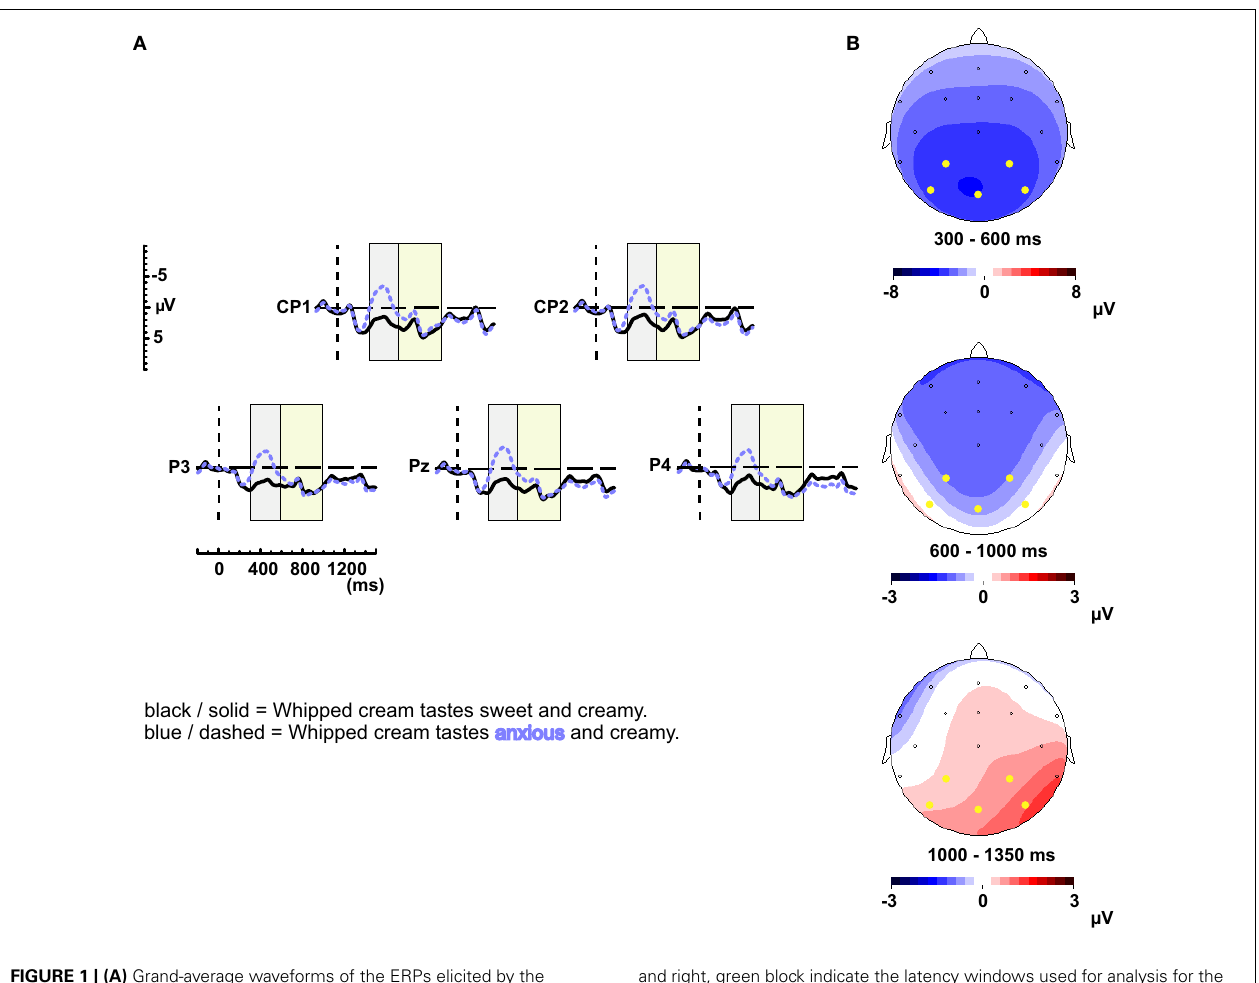
FIGURE 1 | (A) Grand-average waveforms of the ERPs elicited by the semantic anomalies (dashed, blue line) and their correct controls (solid, black line) for electrodes CP1, CP2, P3, Pz, and P4. In this and all following figures the waveforms are time-locked to the onset of the critical word (0ms) and negative voltage is plotted upward. Furthermore, an 8Hz low-pass filter has been applied for illustrative purposes.The left, gray block